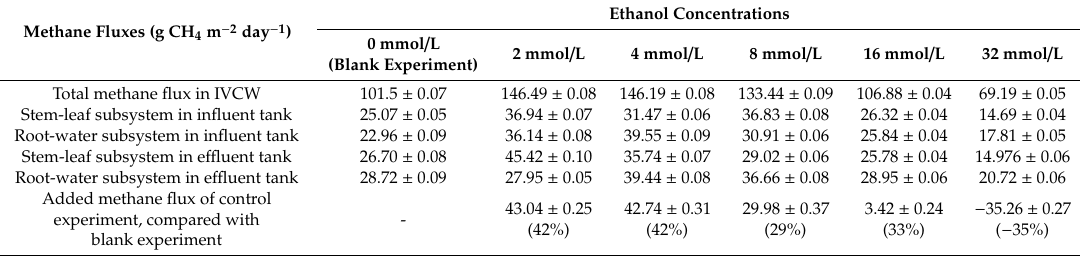
Table 2. Methane emission flux of each ethanol concentration in the